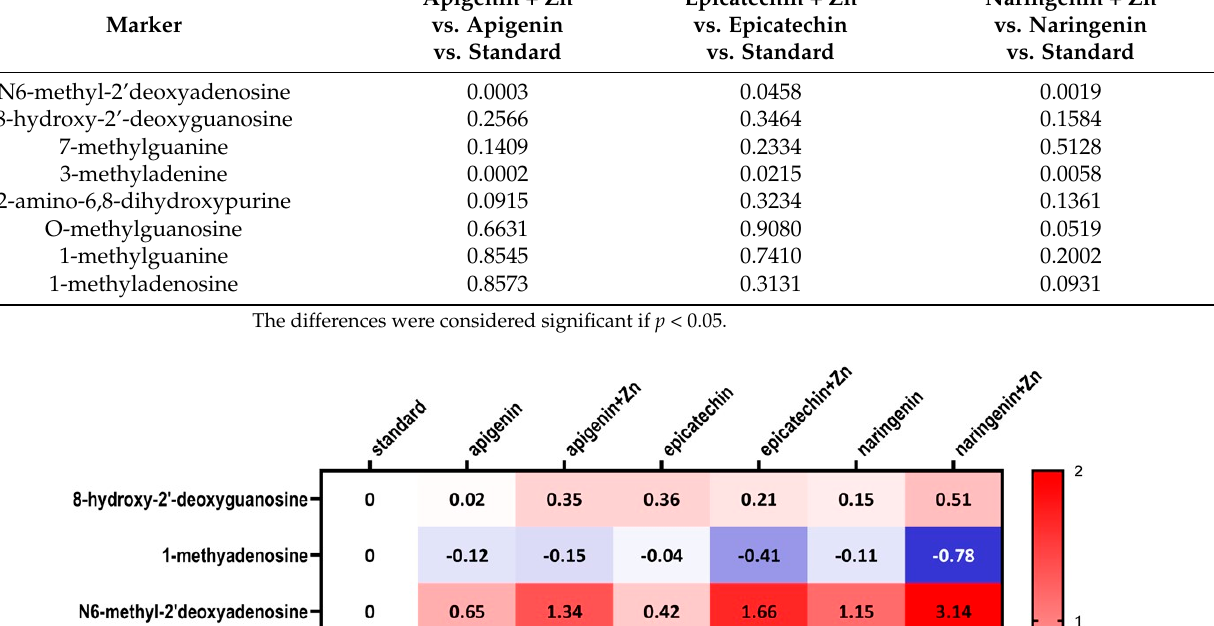
Figure 5. Heatmap of changes of the selected methyl nucleosides derivatives contents depending on the type of supplementation used compared to standard group (i.e., group 1). Table 2. The results of significance differences among means of experimental groups.